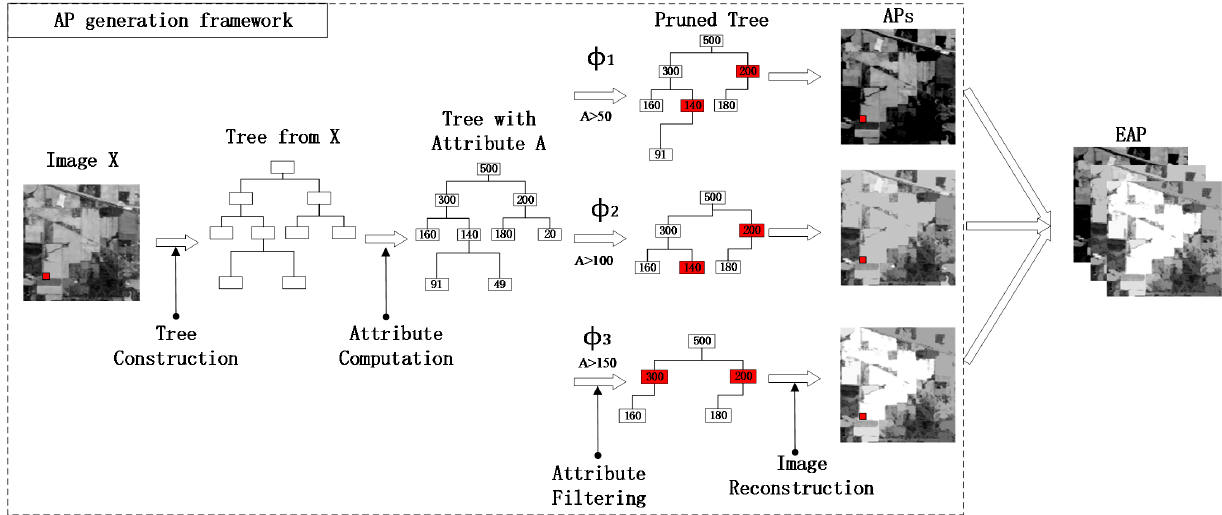
Figure 4. Morphological Attribute Profiles (APs) and Extended APs (EAPs) for base image X